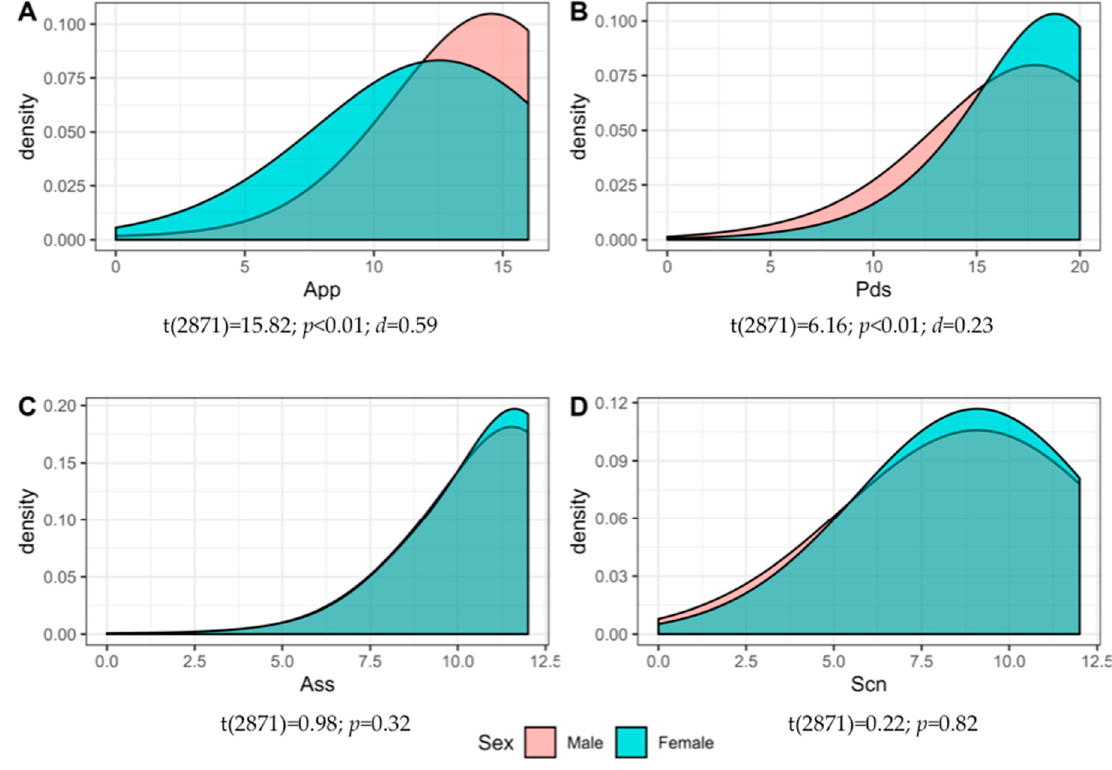
Figure 2. Densiogram distribution across gender. ( A ) gender di ff erences in appropriation (App); ( B ) gender di ff erences in partner’s disapproval (Pds); ( C ) gender di ff erences in assertiveness (Ass); ( D ) gender di ff erences in self-control (Scn).